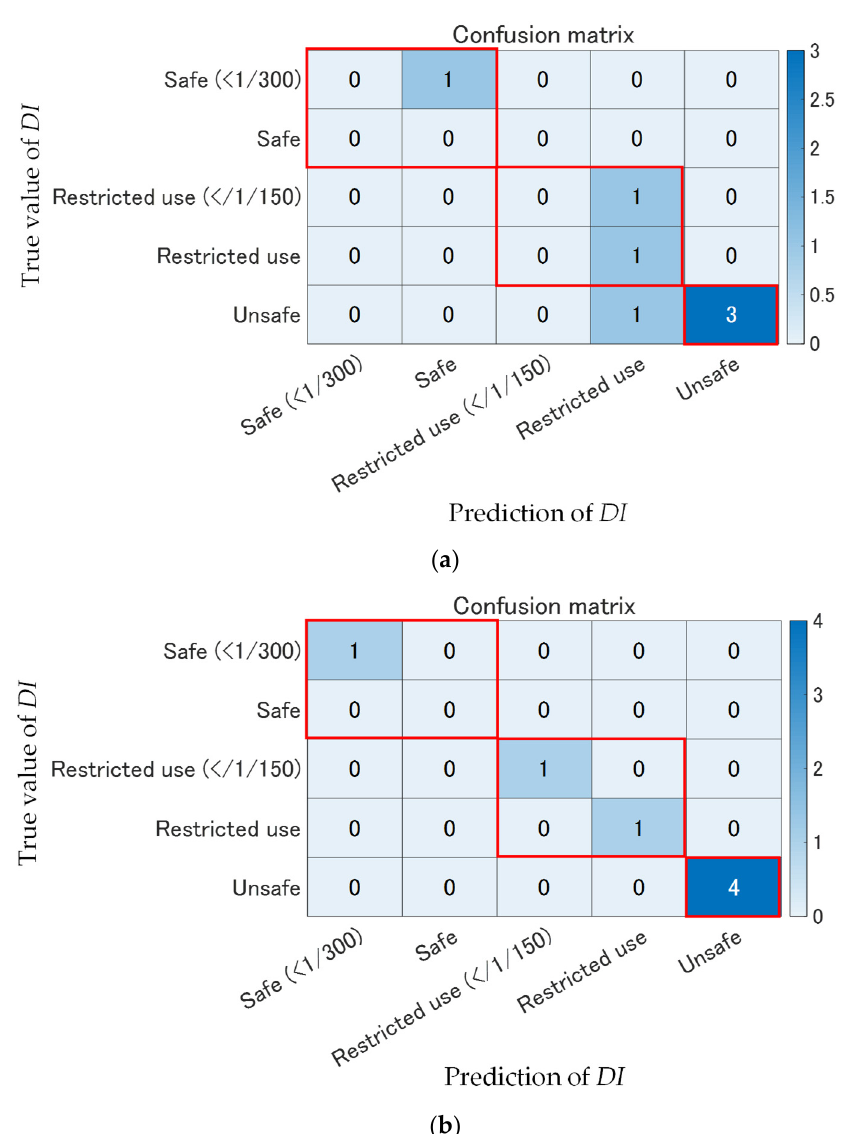
Figure 14. Safety classification using the confusion matrix with the BMU and SRIM methods: ( a ) Results of confusion matrix using parametric model updating (BMU method); ( b ) results of confusion matrix using nonparametric system identification (SRIM method).